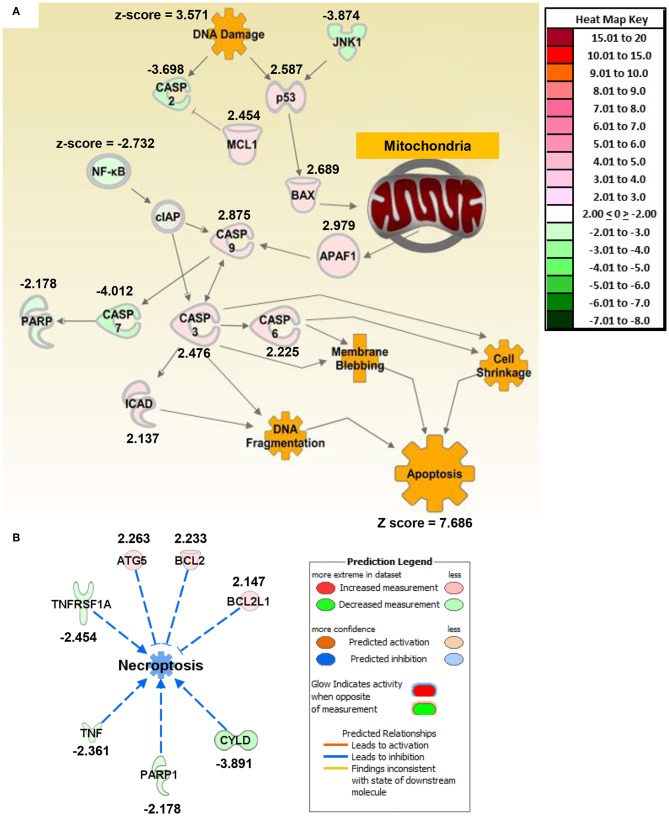
Macrophage exposure to Magnéli phases activates gene expression profiles associated with apoptosis and mitochondria dysfunction. (A) Gene expression was evaluated using real time PCR based Superarrays (Qiagen). For each gene target on the array, fold change was calculated based on ΔΔCt values. Genes found to be ±2-fold change in expression from untreated specimens were defined as significant. The resultant data was evaluated using Ingenuity Pathway Analysis (IPA) to define pathways and global correlations between gene expression profiles and biological functions. Cell death signaling, specifically apoptosis, was the top pathway up-regulated in the macrophages following Magnéli phase exposure. IPA further identified gene expression profiles consistent with mitochondria dysfunction as a potential factor associated with the increased apoptosis signaling. (B) Pathways associated with inflammation and specifically inflammation associated cell death (i.e., pyroptosis and necroptosis) were significantly down-regulated at the level of gene transcription. Either fold change in gene expression or z-score values are displayed for each node as appropriate.